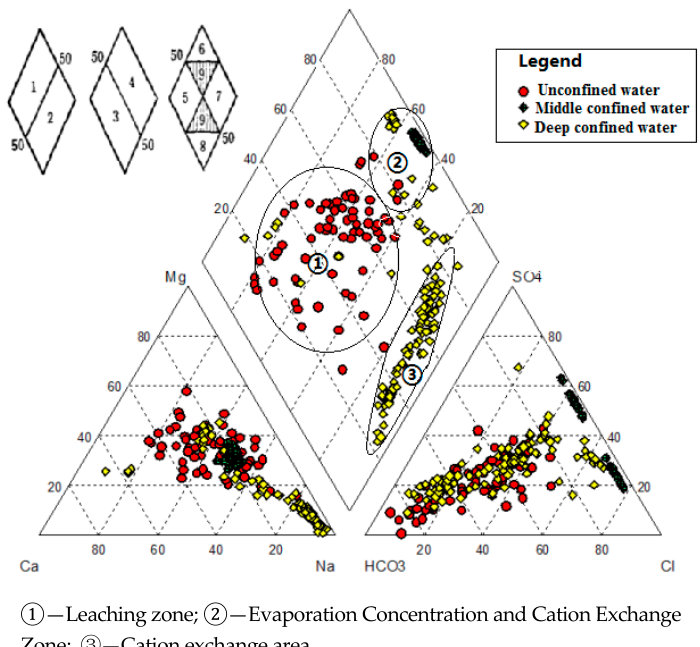
Figure 6. The Piper diagram for shallow unconfined water, middle confined water and deep confined water.